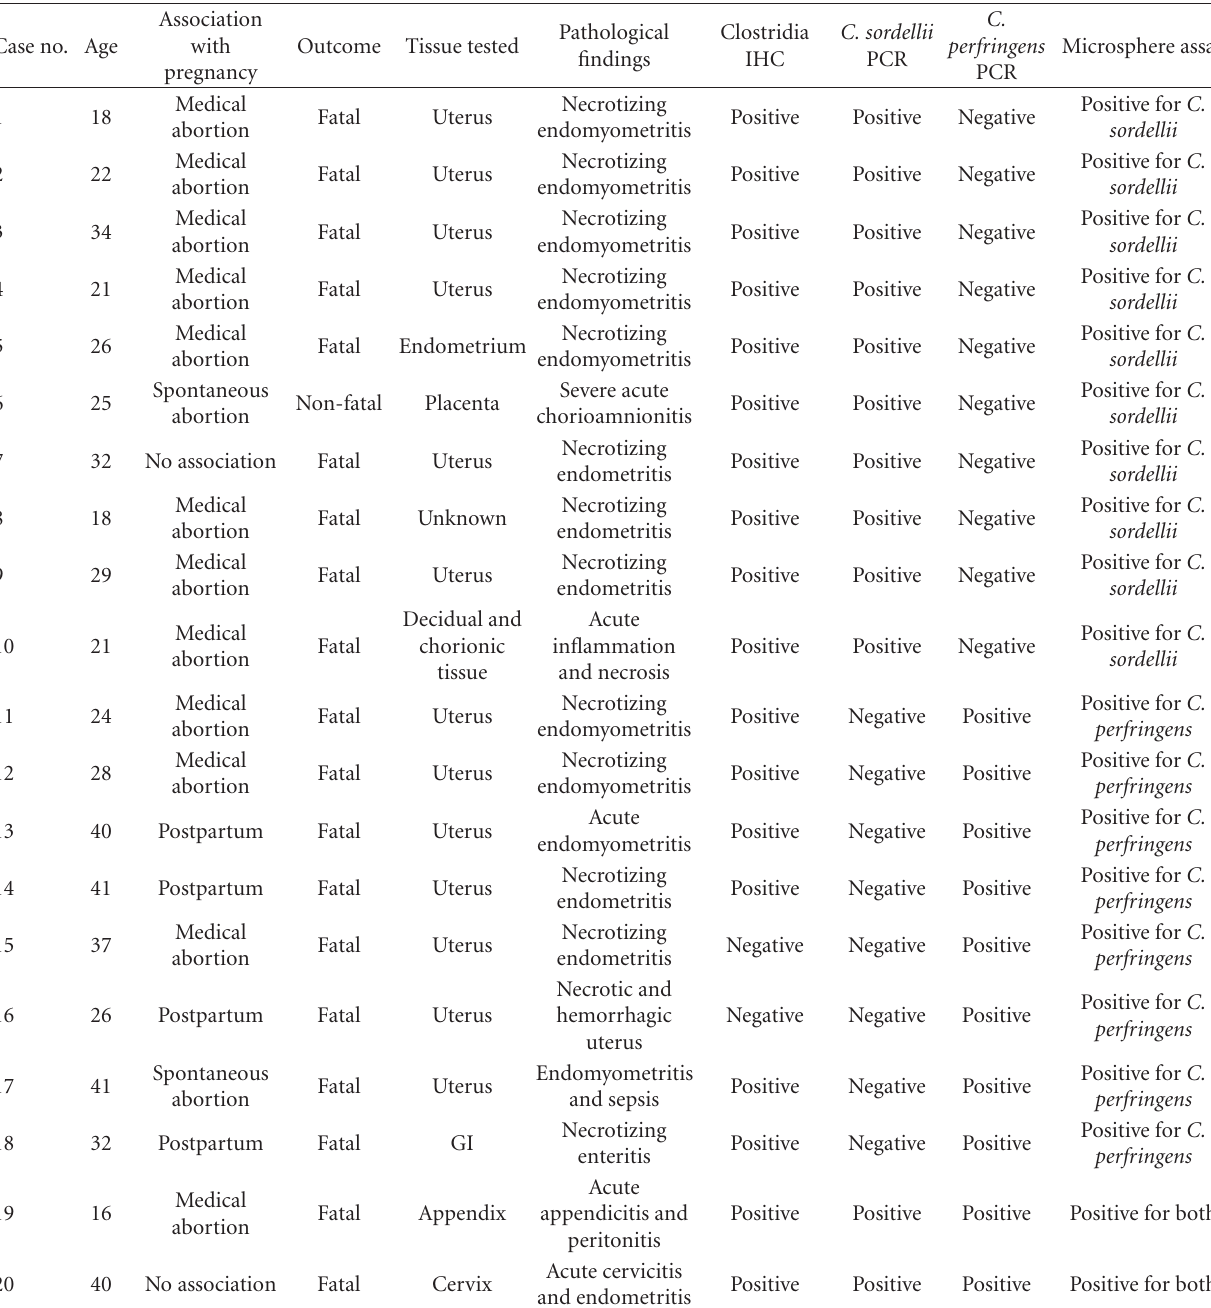
Table 2: Demographic, clinicopathological findings, and case-by-case comparison of IHC, PCR, and microsphere assay results. Case no.